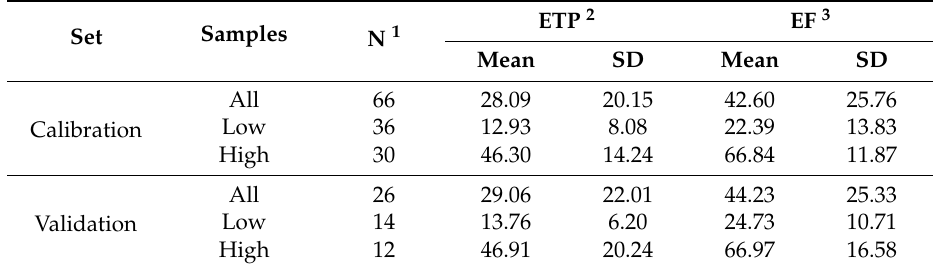
Table 3. Extractability levels of total phenols and flavanols for grape seed samples allocated in calibration and validation sets. Means and standard deviations are shown.